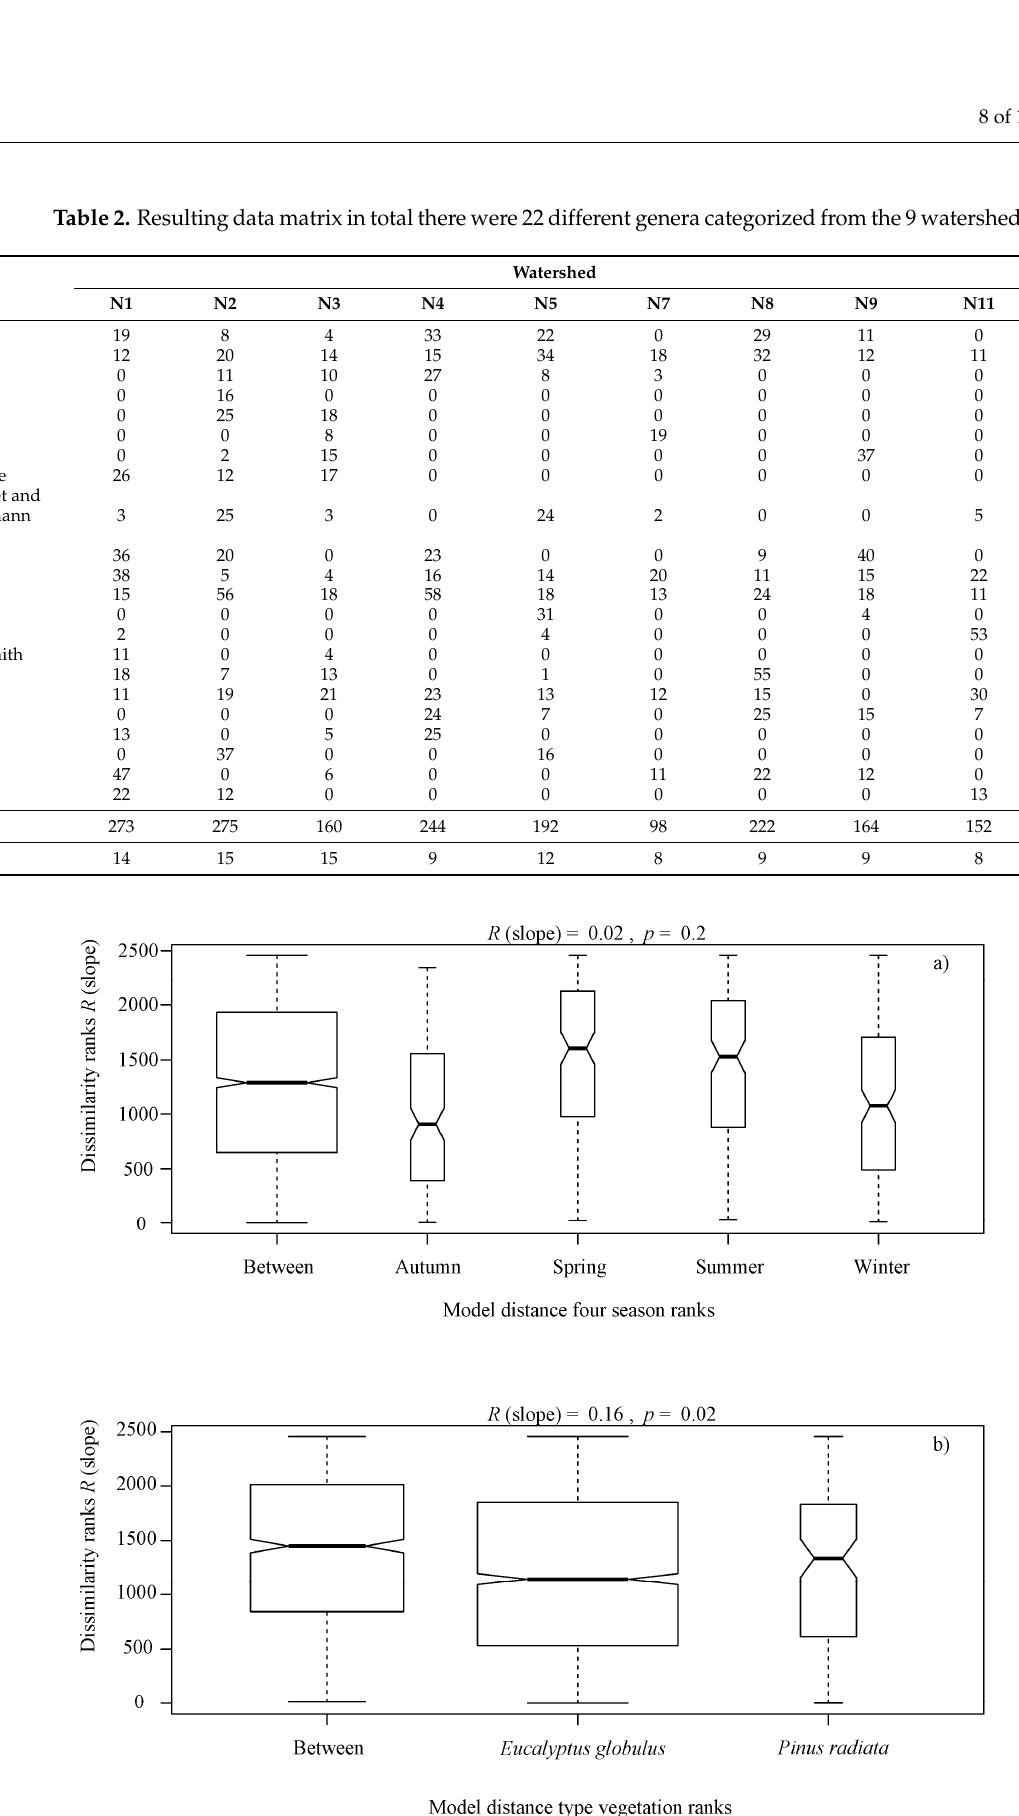
Figure 3. Box plot of rank dissimilarities ( R (slope)) among the 9 sites against the four seasons ranks (Autumn, Winter, Spring and Summer) ( a ), and type vegetation ranks ( Eucalyptus globulus and Pinus radiata ) ( b ), from a serial ordering model of groups.